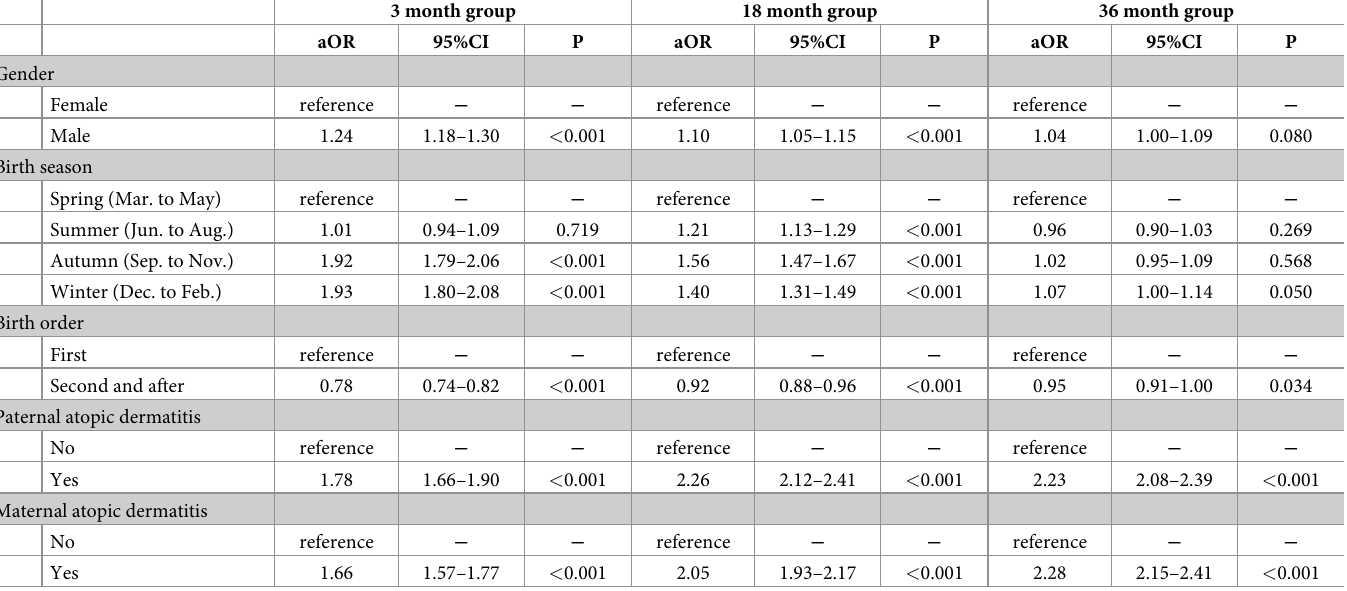
Table 6. Multivariable analysis between eczema and covariates in the three age